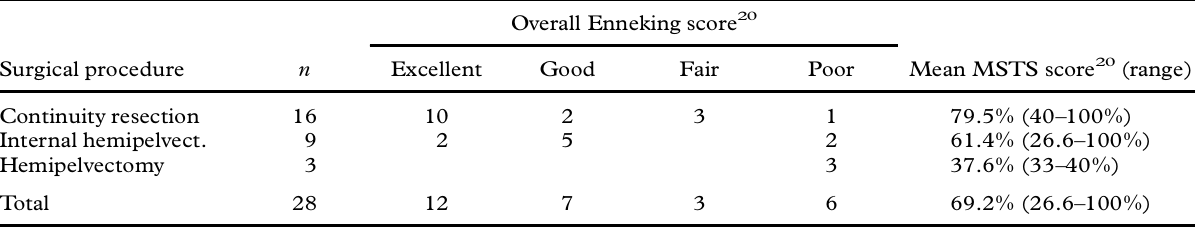
MSTS, MusculoskeletalTumor